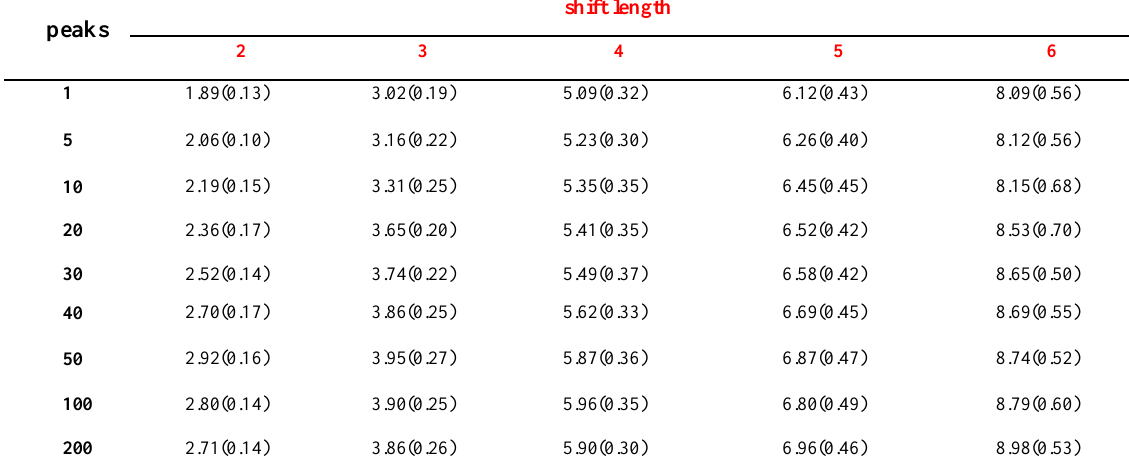
Table 8. Offline error for proposed algorithm with frequency change = 5000 and different peaks and different dimensions and shift length = 1.